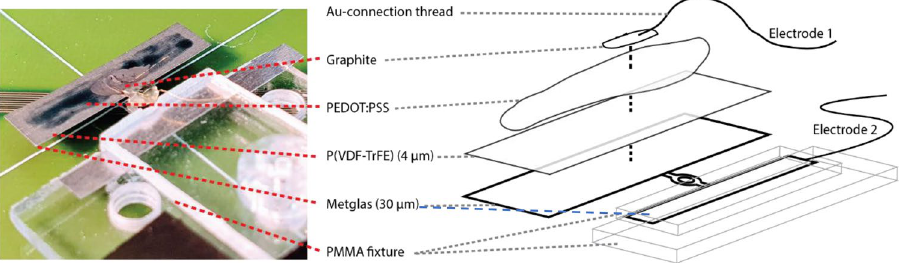
Figure 1. Sample setup showing the laminate structure comprised of Metglas film (magnetostrictive), P(VDF- TrFE) layer (piezoelectric) and PEDOT:PSS layer (conductive polymer) with a graphite dot to attach the thin Au wire (electrode 1). The second electrode (electrode 2) is connected to the metallic Metglas film that is clamped by the PMMA structure. For the non-contact measurements (capacitive coupling) an electrode was placed at various distances above the PEDOT:PSS layer, and electrode 2 was connected with contact to the clamped Metglas film to the electronics (see Fig.